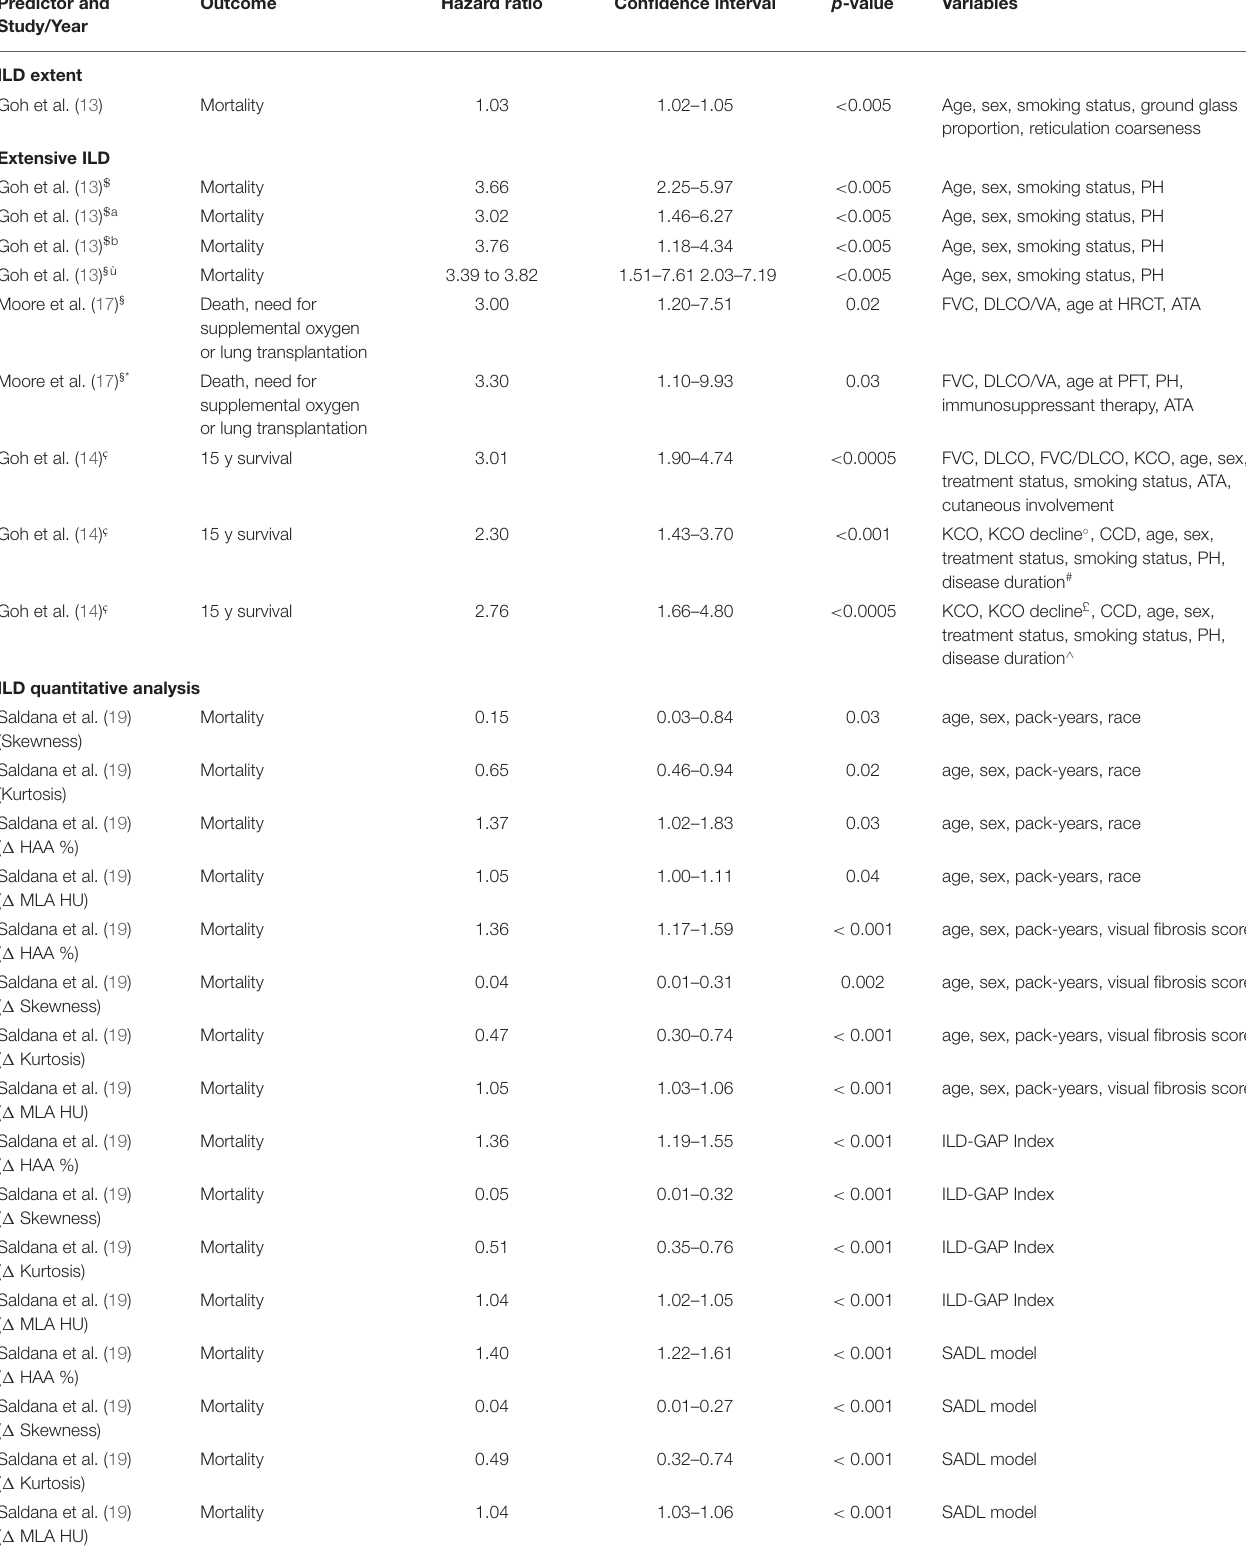
TABLE 3 | Independent predictors of mortality in ILD-SSc, multivariate analysis. Predictor and